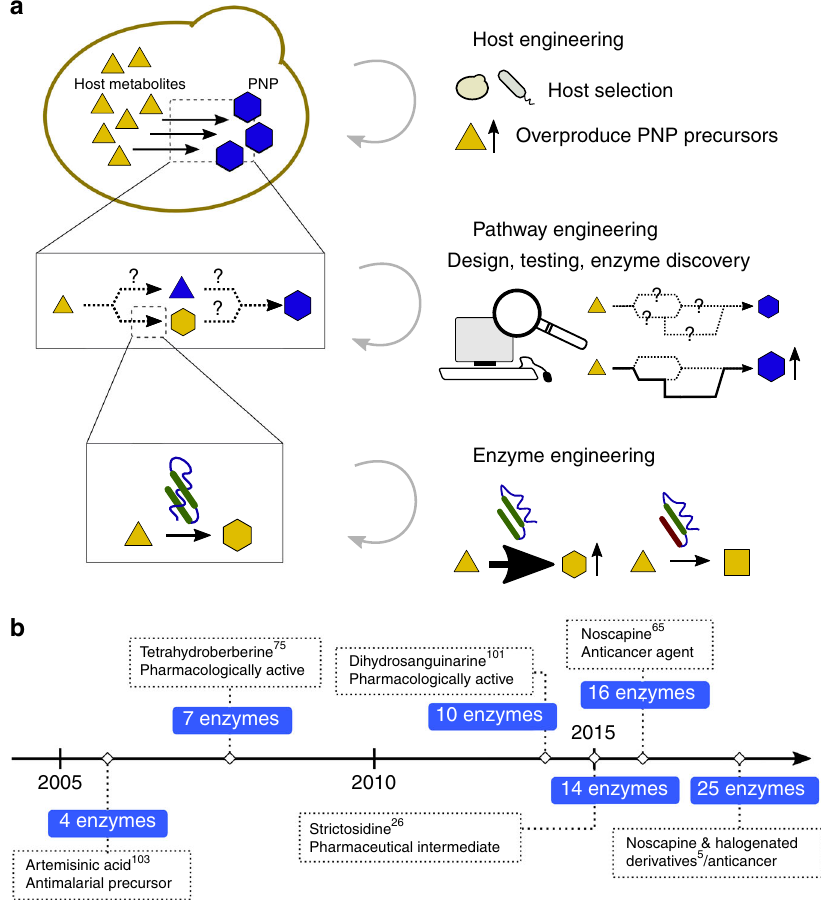
Fig. 1 Metabolic engineering at multiple levels has enabled engineering of increasingly complex heterologous PNP pathways. a Heterologous production of a PNP in a microbial host can involve engineering at three different scales: host, pathway, and enzyme. b Timeline of examples of notable yeast-produced PNPs, showing increasing pathway length accomplished over time. Labels show product name or compound